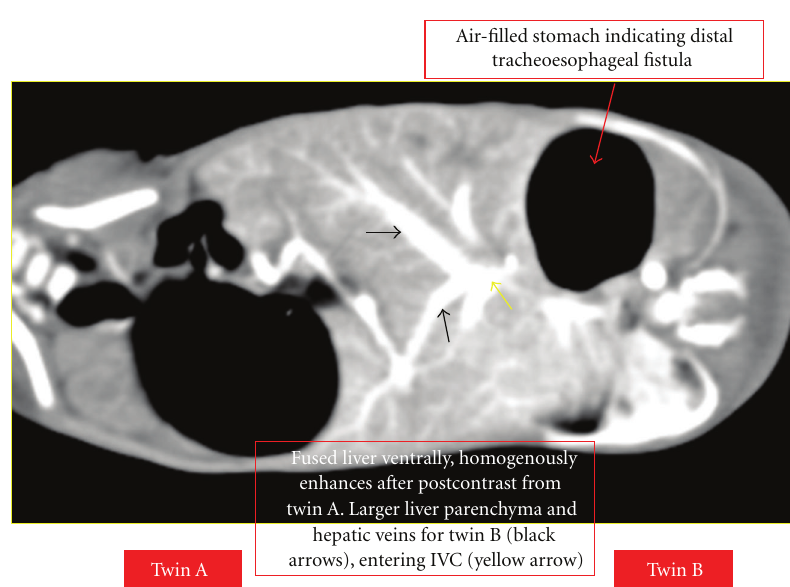
Figure 3: Contrast-enhanced image of